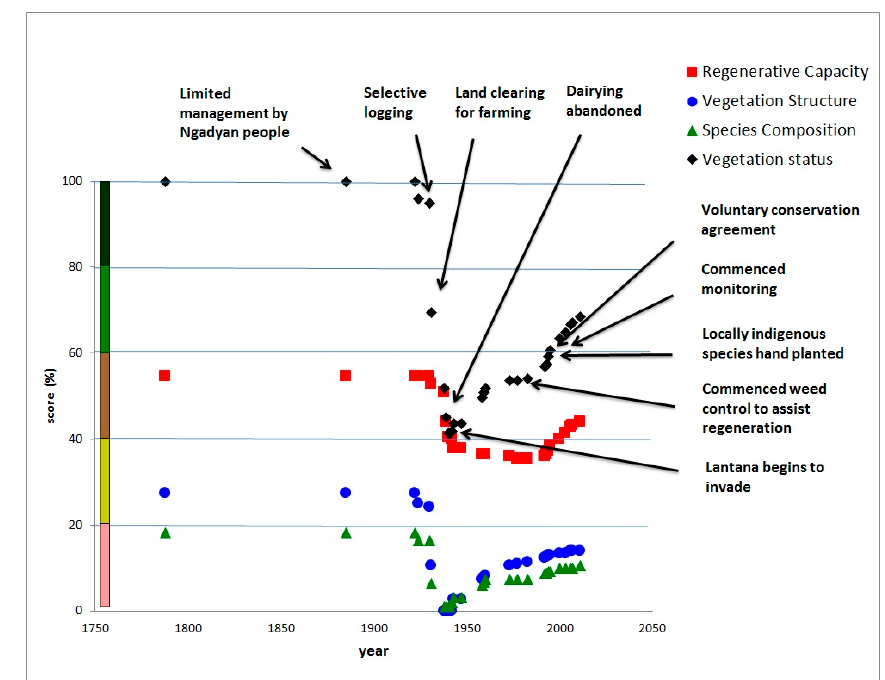
Figure 9. Case study 8: North Molle Island, Molle Group, Cumberland Islands, tropical warm season moist agro-climate region, Imperata and Themeda tussock grassland. Land 2016 , 5 , 40